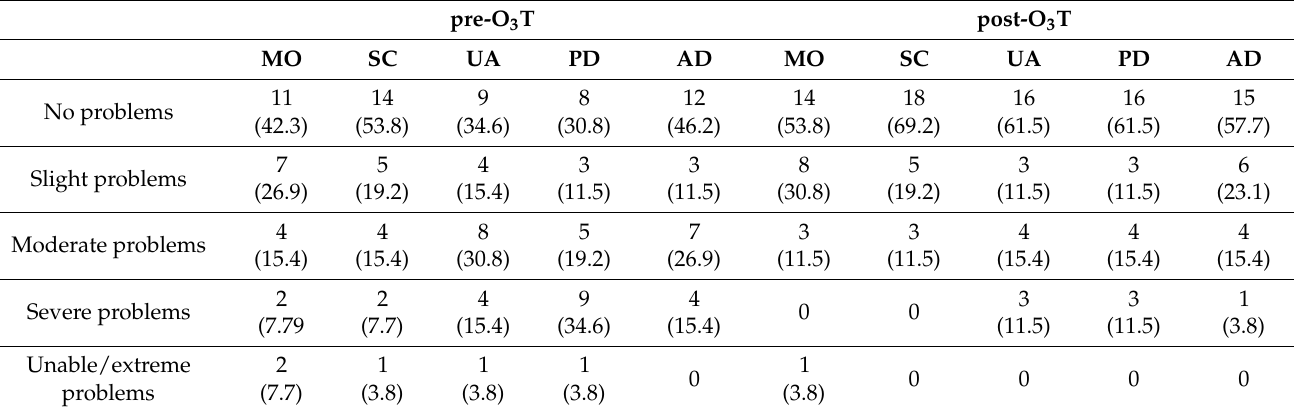
Table 2. Descriptive answer of each EQ-5D-5L dimension by time, n (%). MO: mobility; SC: self-care capacity; UA: ability to carry out the activities of daily living; PD: pain or discomfort; AD: anxiety or depression.